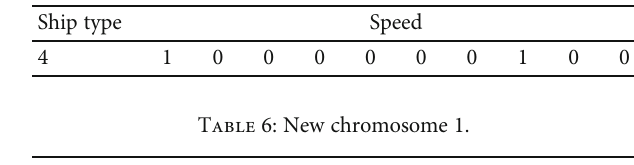
Table 5: Original chromosome 2.